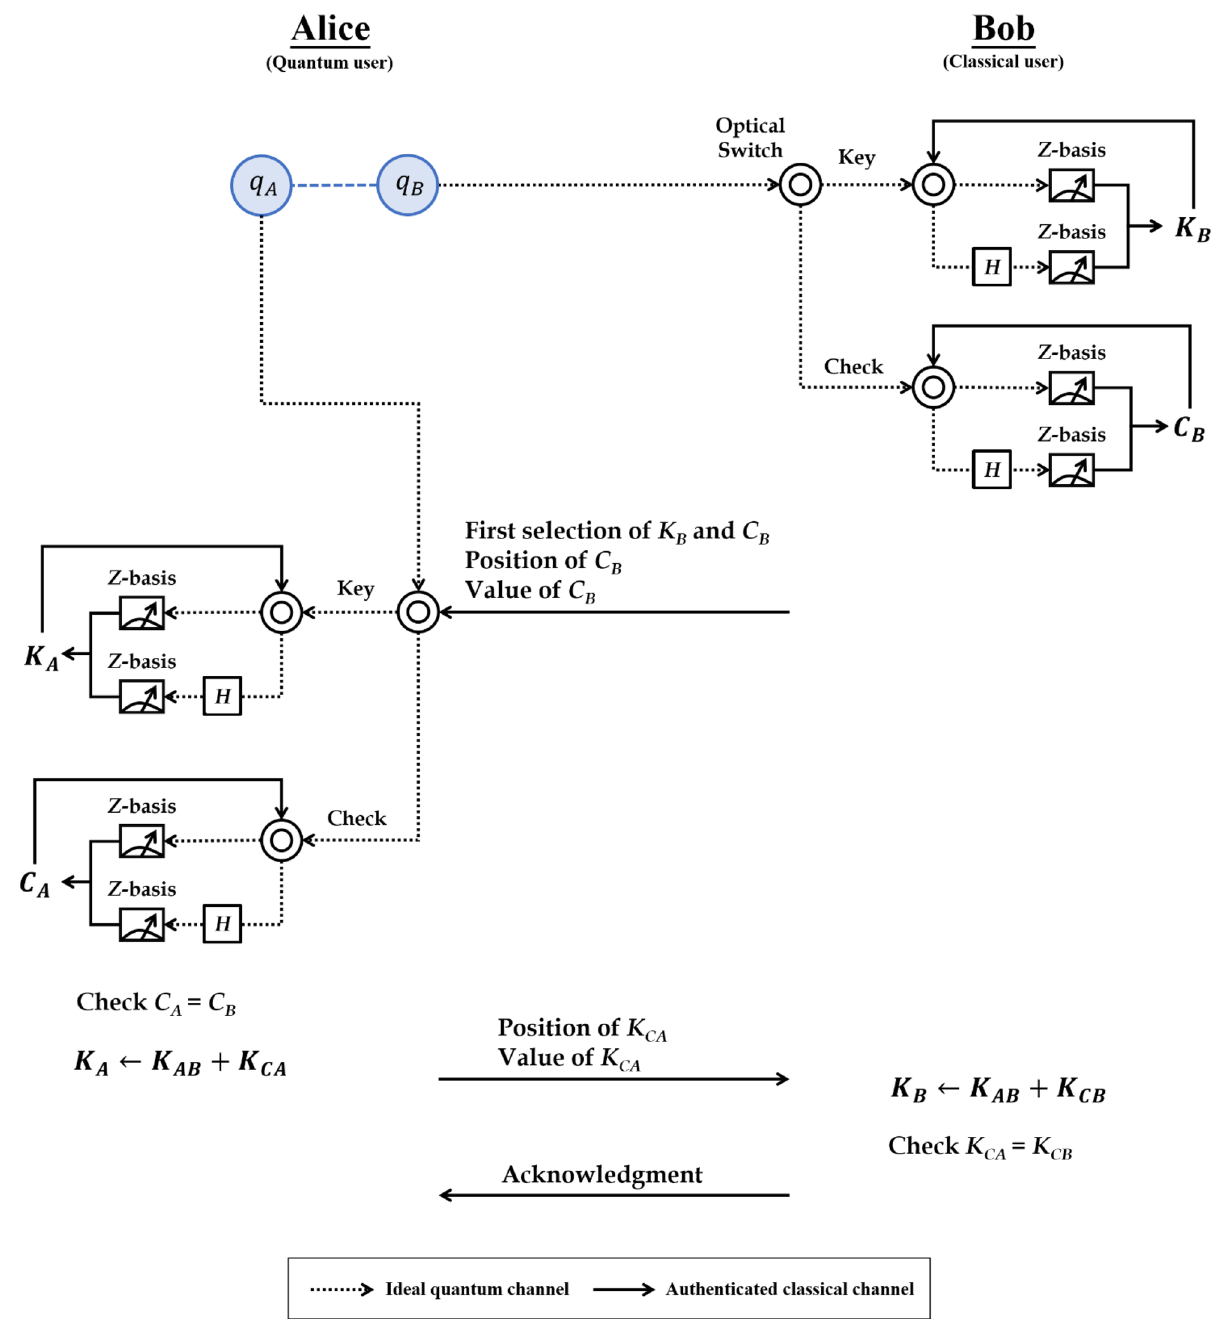
Figure 2. Operational procedure of the proposed SQKD